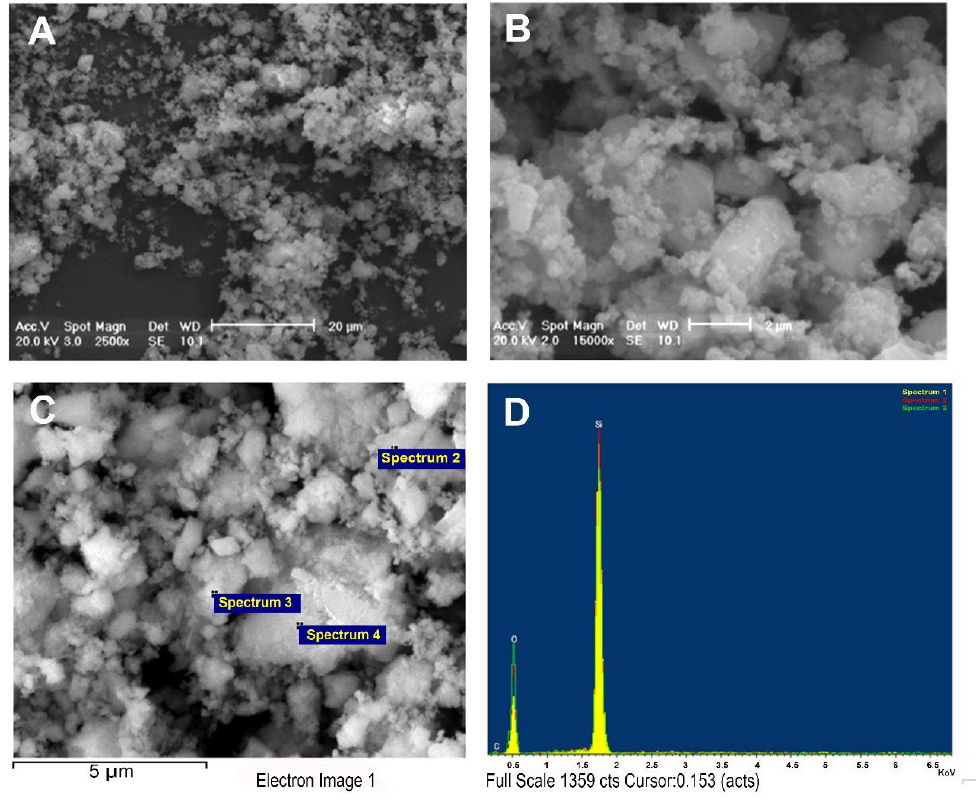
Figure 2. Scanning electron microscopy (SEM). Analysis of silica microparticles at different magnifications ( A – B ) and relative elemental spectrum with EDS ( C – D ).